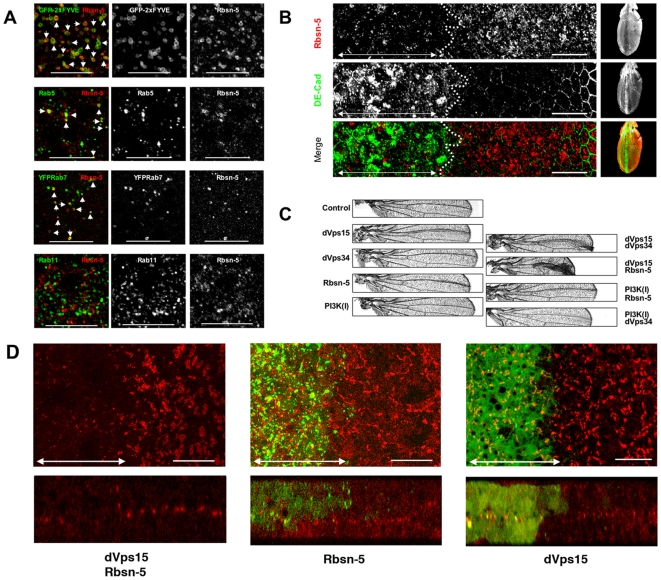
Rbsn-5 is a PI(3)P target protein.(A) Rbsn-5 (red) was co-localized in the pupal wing discs, mainly with GFP-2xFYVE, Rab5 and Rab7 (arrowheads), but not with Rab11. The scale bars represent 20 µm. (B) Rbsn-5 (red) was clearly reduced in the dVps15-knockdown region (the left sides of the dotted lines). In the knockdown region, DE-Cadherin (green) accumulated intracellularly as shown in Figure 4. (C) Adult wings in which dsRNAs were expressed by dpp-Gal4 driver. Malformation was observed near the third vein where the dsRNAs for dVps15, dVps34 or Rbsn-5 were expressed. This malformation was synergistically enhanced by co-expression of dsRNAs for both dVps15 and dVps34 or both dVps15 and Rbsn-5, whereas no such enhancement was observed by co-expression of dsRNAs for both PI3K class I and Rbsn-5 or both PI3K class I and dVps34. (D) Horizontal (upper) and vertical (lower) sections of the pupal wings expressing dsRNAs for Rbsn-5 and/or dVps15. β-integrin (red) was not localized in the double knockdown region (indicated by double headed arrow in the left panel) whereas marginal defects were observed in the single knockdown (indicated by double headed arrows in the middle and right panels). The right sides of the panels represent the internal control where β-integrin was normally localized to the basal junctions. The scale bars represent 10 µm.